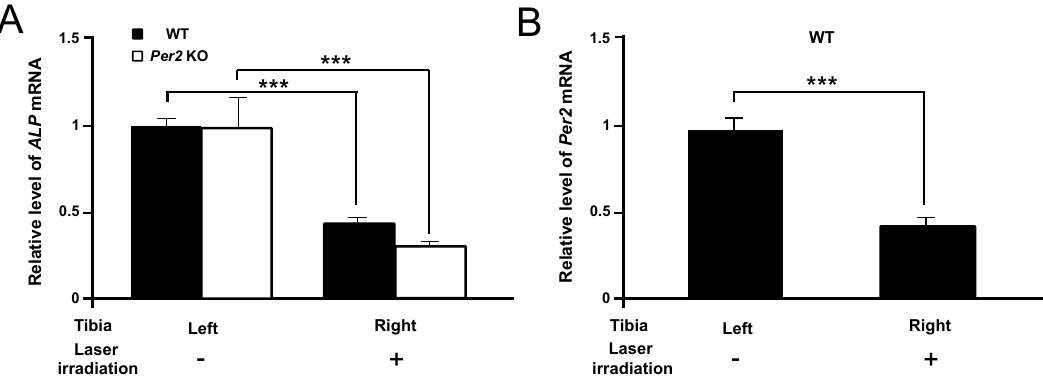
Figure 3. The expressions of ALP ( A ) and Per2 ( B ) mRNAs in tibial bone marrows of WT and Per2 KO mice, respectively, in 405 nm LLLT using MILNS. The data are mean ± SEM ( n = 3). Statistical significance is indicated by *** p < 0.001.